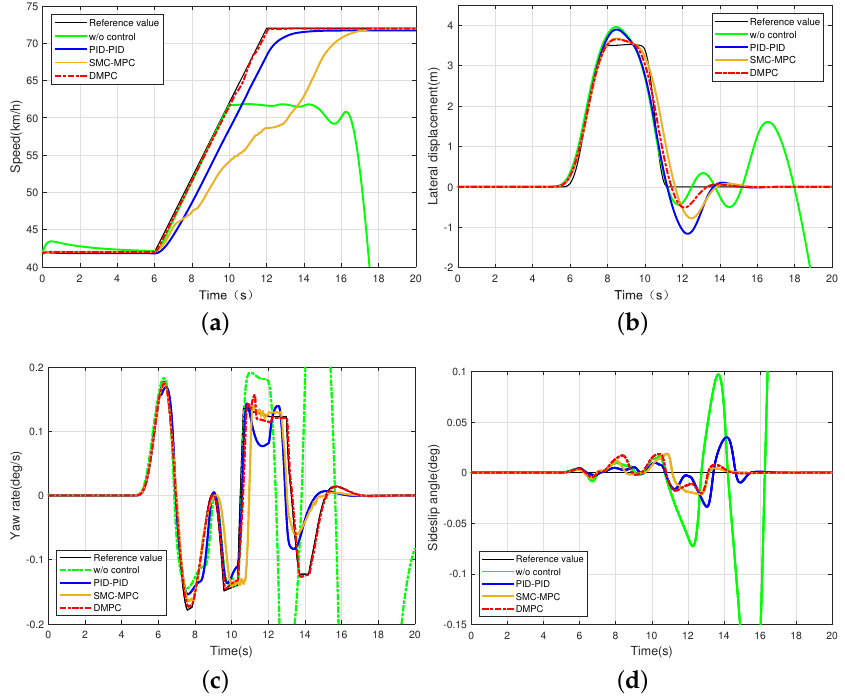
Figure 6. FWID-EVs performance in low-adhesion DLC conditions. ( a ) Longitudinal velocity; ( b ) lateral displacement; ( c ) vehicle yaw rate; ( d ) vehicle side-slip angle.